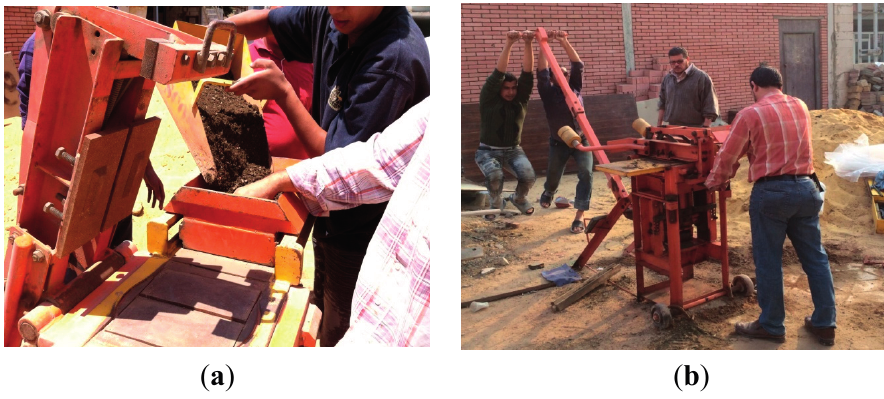
Figure 3. ( a ) Filling the mold with the mix using a bucket; ( b ) Manual pressing using Compressed Earthen Block (CEB) machine.